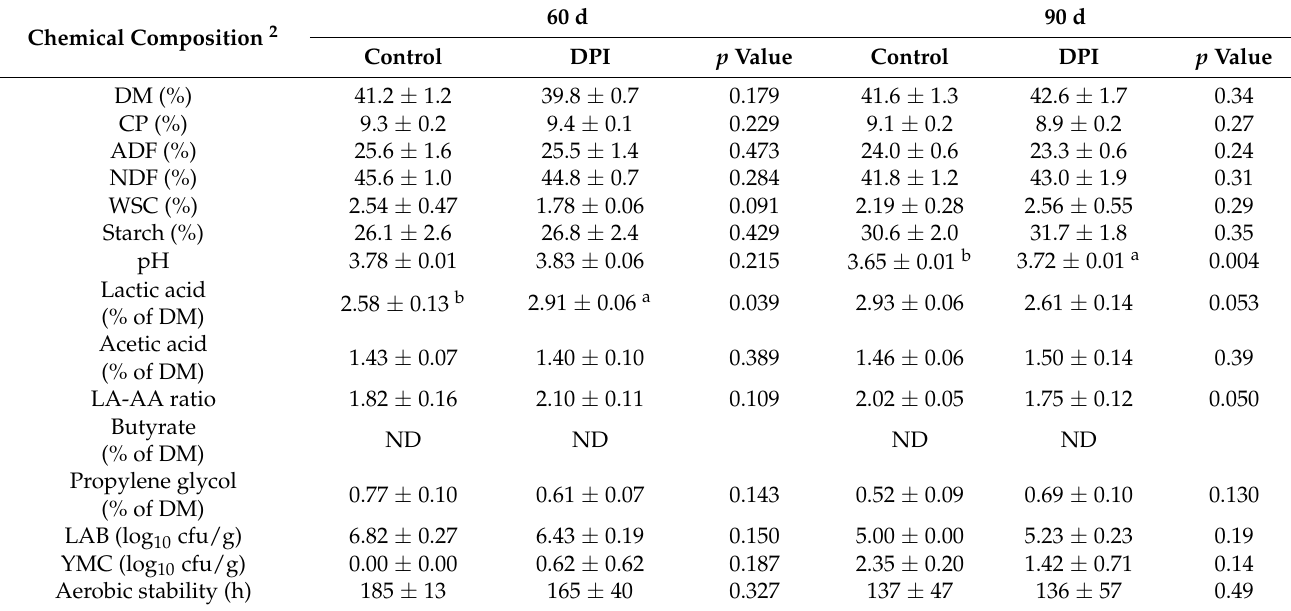
Table 2. Effects of inoculant application 1 on the quality and chemical composition of baled silage at different ensiling periods. Chemical Composition